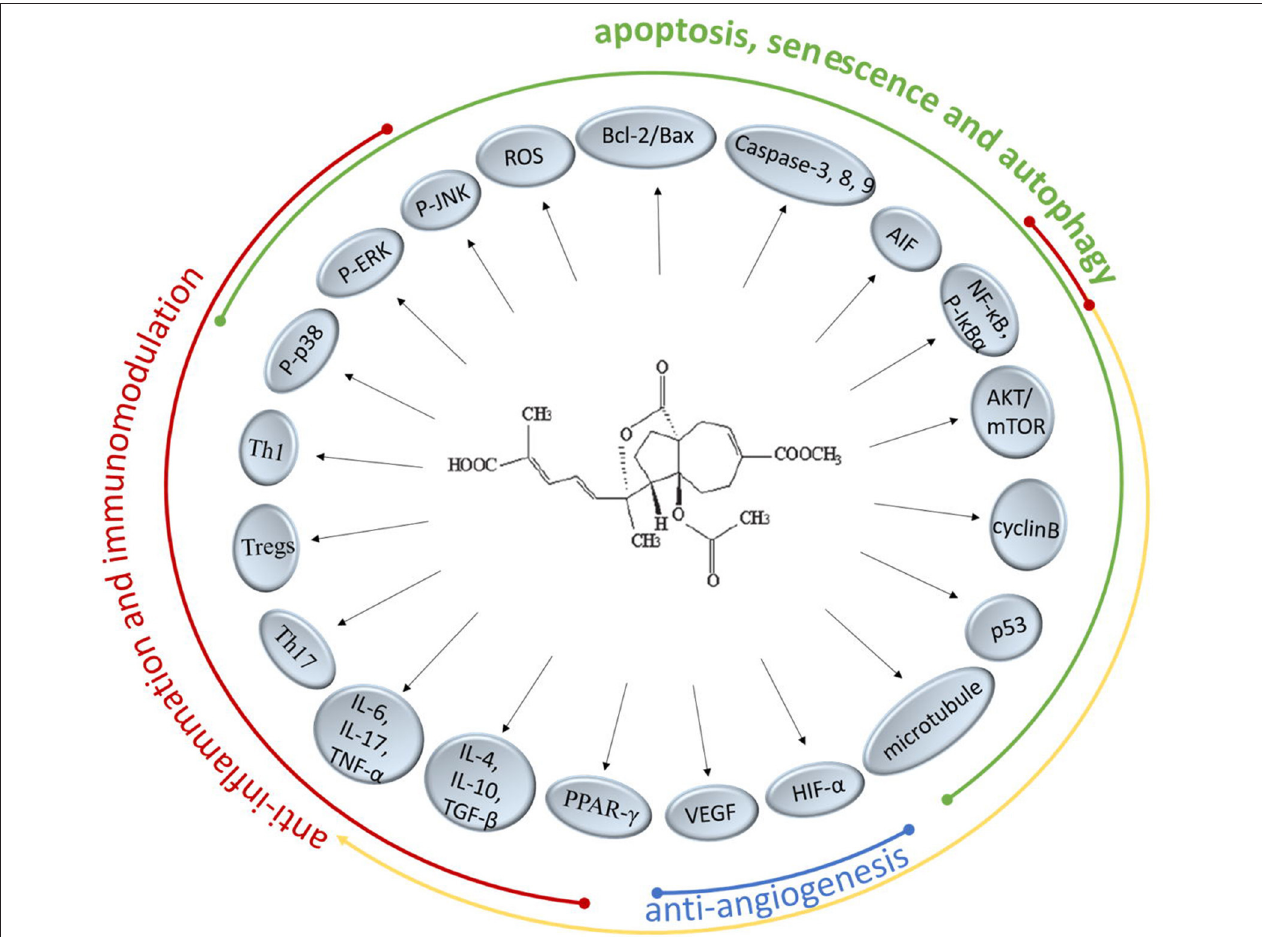
FIGURE 2 | Molecular targets and pathways of